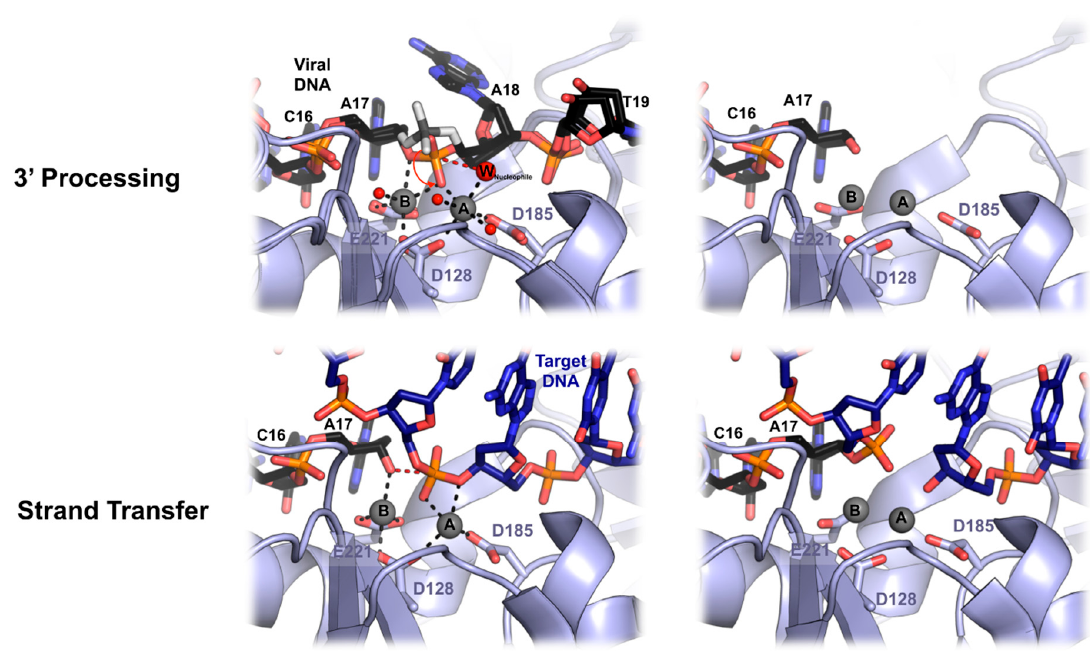
Figure 5. Mechanics of PFV 3’processing and strand transfer. Top panel, a close up of PFV intasome active site during 3’ processing. Superimposition of intasome structures before 3’ processing with and without bound manganese Mn 2+ (grey spheres A and B) (left) and after cleavage (right). Relocation of the scissile phosphodiester upon metal binding is shown with a red arrow. The red spheres illustrate the water molecules, and the nucleophile water molecule is shown as a big red sphere. Bottom panel, strand transfer activity upon target DNA binding. The nucleophilic attack is shown with red dashes.